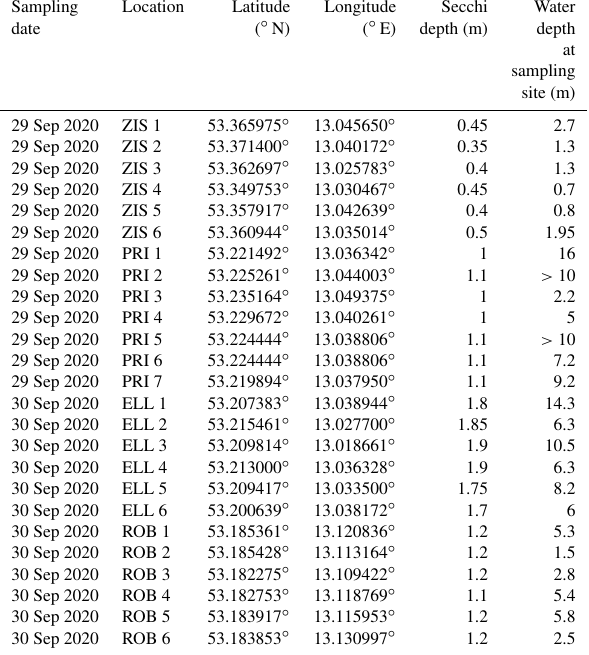
Table 3. Sampling locations for spatial campaigns in Zierker See (ZIS), Großer Priepertsee (PRI), Ellbogensee (ELL), and Röblinsee (ROB) (white dots in Fig. 2). Samples with ID no. 1 are identical to buoy samples as listed in Table 2 and taken from 1m below the water surface.